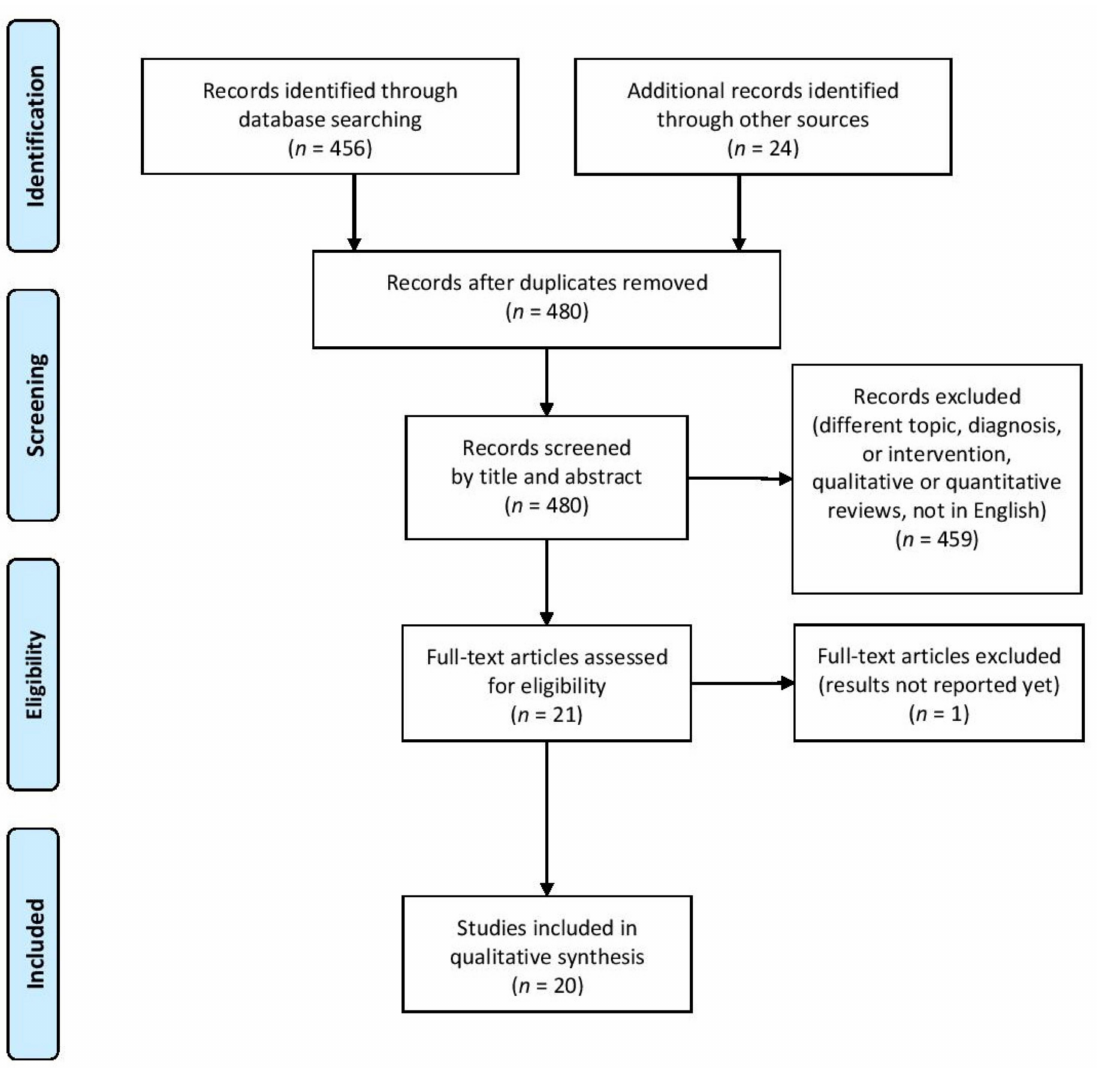
Figure 1. Flow diagram displaying the selection